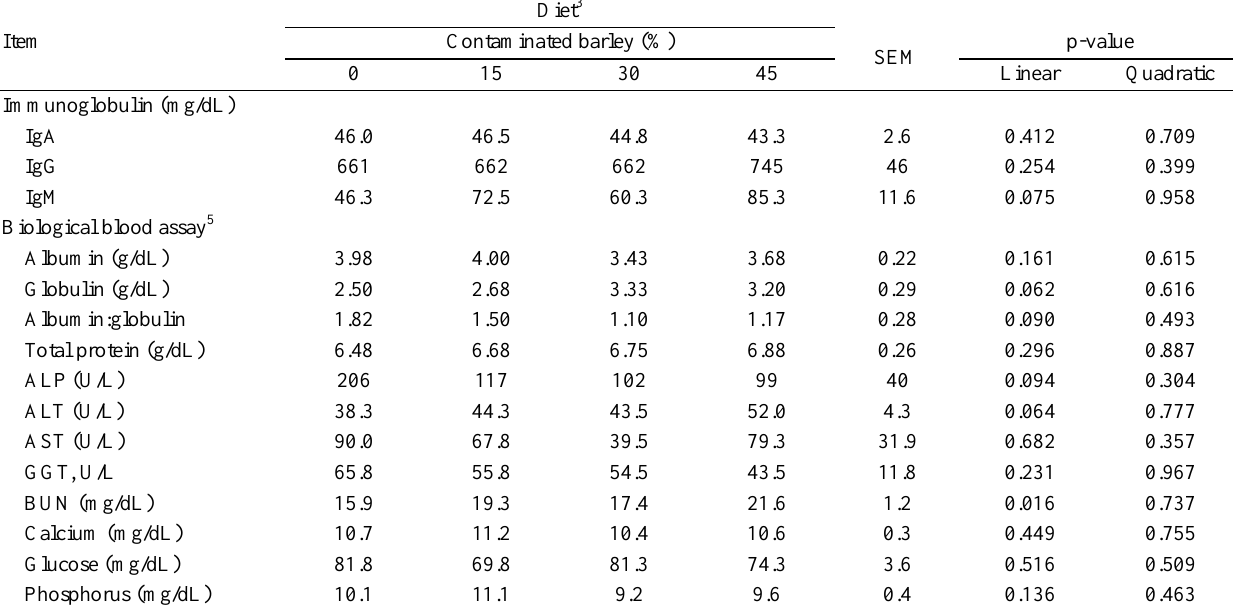
Table 7. Immunoglobulin and biological blood assay of pigs fed experimental diets containing increasing amounts of barley naturally contaminated with Fusarium mycotoxins 1,2 , Exp. 1